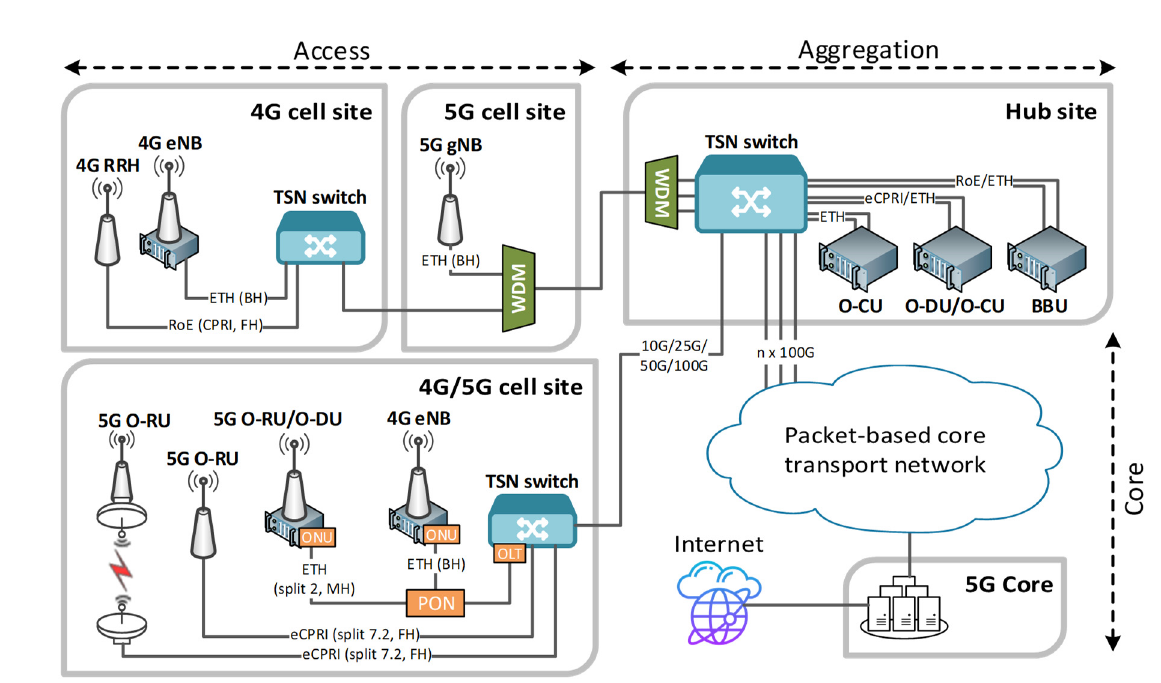
Figure 6. Example of Open Xhaul transport network.